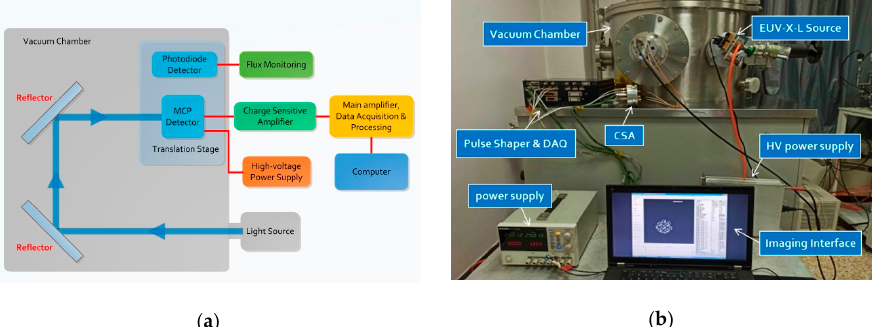
Figure 9. ( a ) Schematic of the experimental setup for the system test. ( b ) Photograph of the laboratory test apparatus. Except for the MCP detector and the photodiode in the vacuum chamber, the rest of